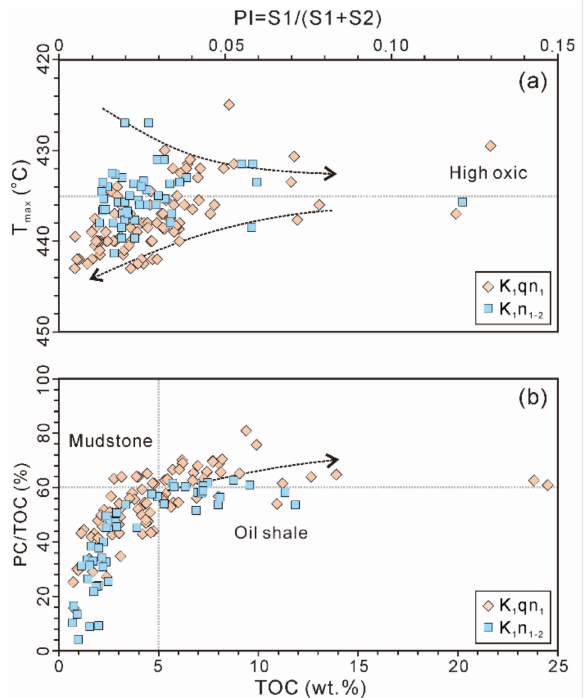
Figure 10. Plots of PI and T max ( a ), TOC and PC/TOC ( b ) for oil shales and mudstones in the K 2 qn 1 and K 2 n 1-2 . Partial data of TOC and PC/TOC in the K 2 qn 1 are from